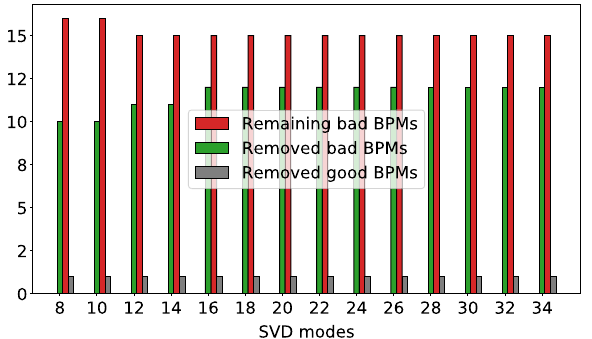
FIG. 12. The relation between BPM cleaning results and the change of the number of SVD modes used in analysis.